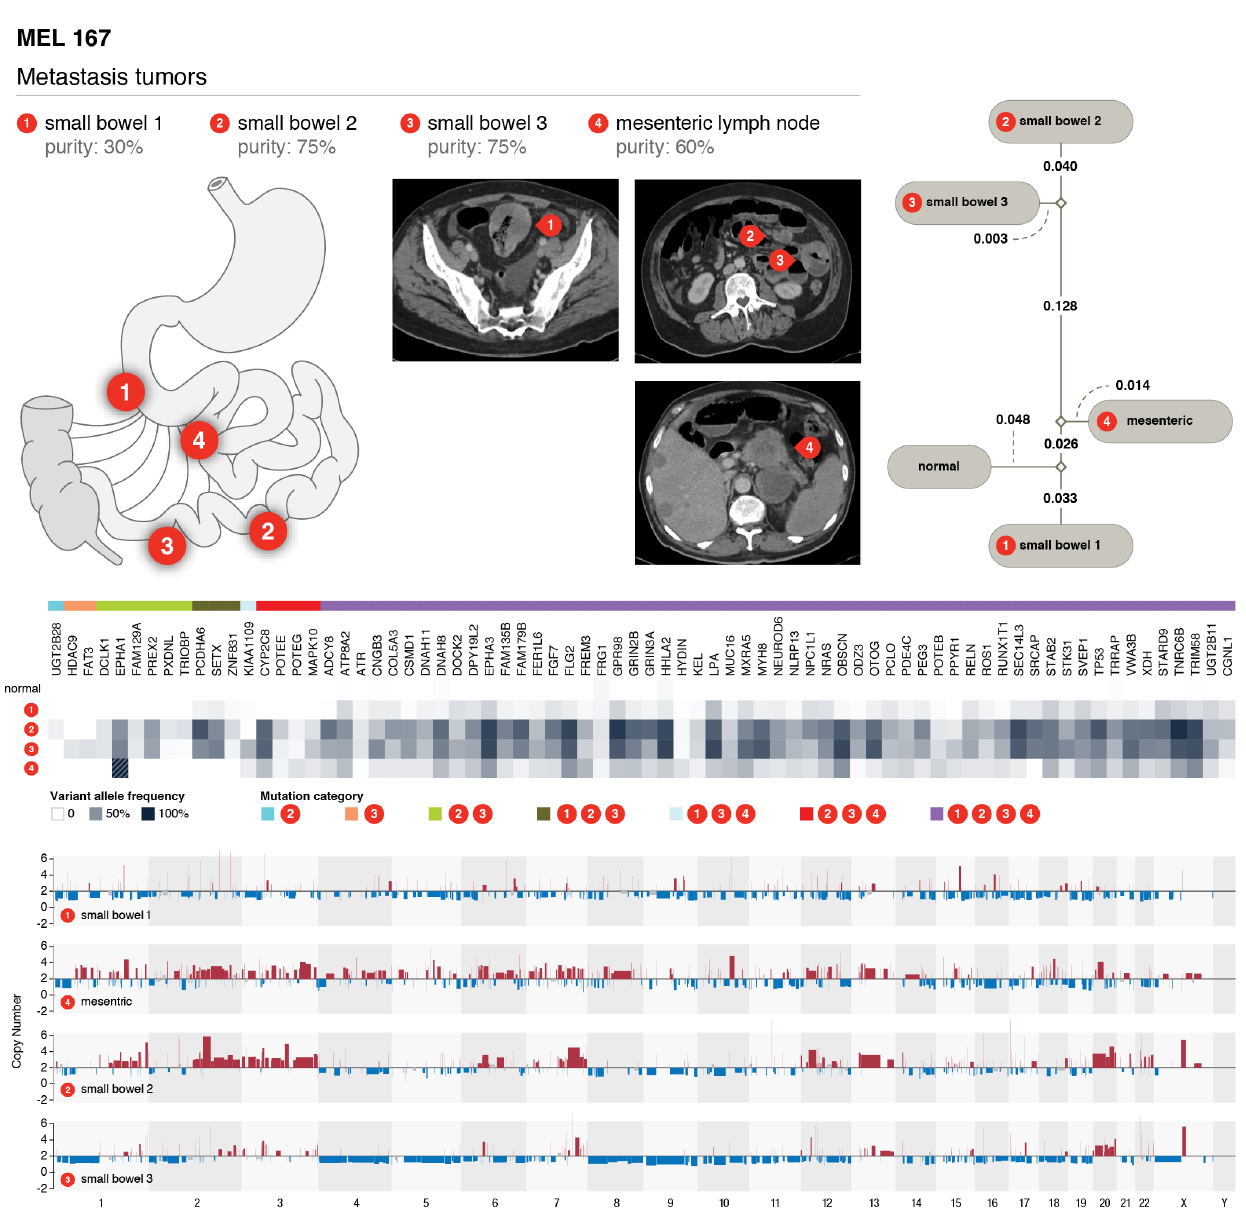
Figure 7. Phylogenetic and mutational relationships among four metastatic samples from different sites of the same individuals (MEL 167). Geographic locations and CT scans of metastasis samples in MEL167 with three tumor samples from small bowel (mass 1, mass 2, and mass 3) and one from mensenteric lymph node. Phylogenetic relationships, mutation patterns, and copy number landscape in all four tumors were shown. Purity based VAF corrections were applied prior to phylogenetic